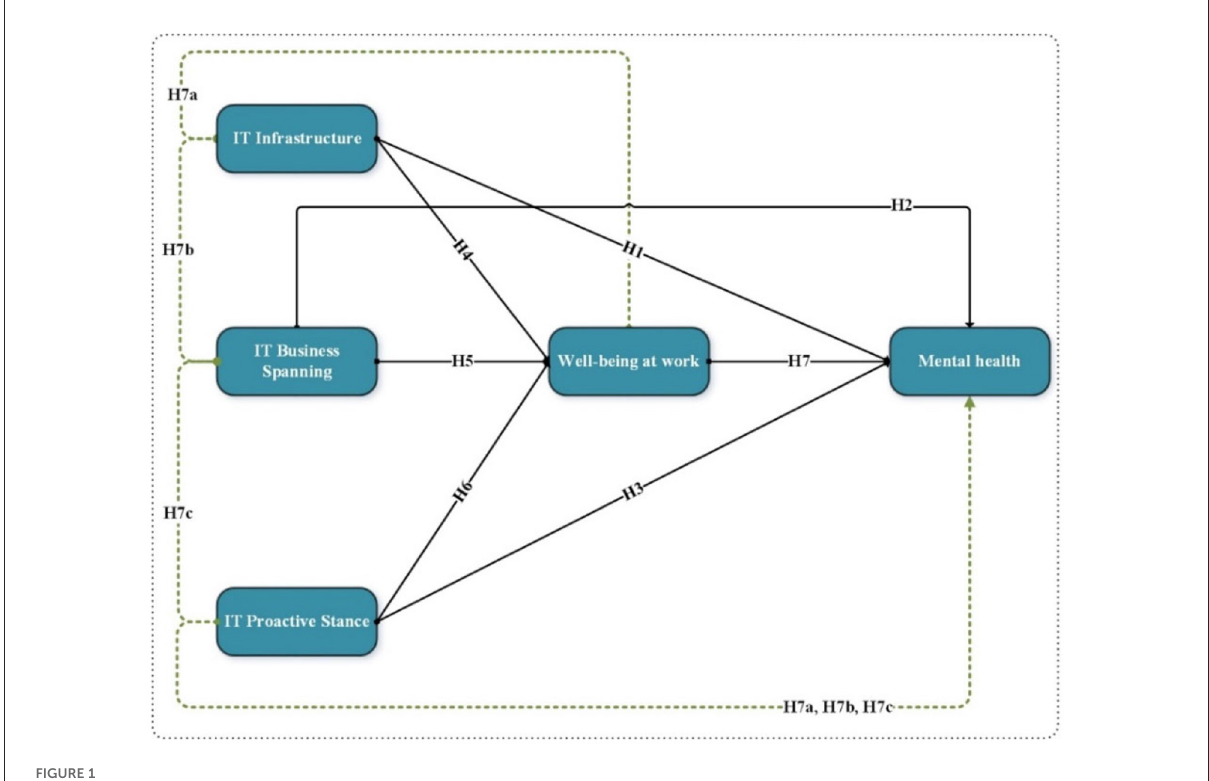
FIGURE1 Conceptual